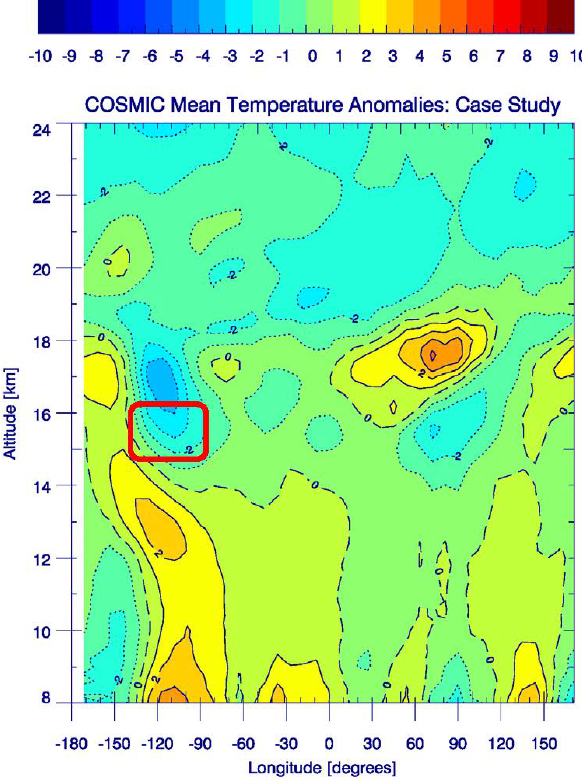
Fig. 7. Temperature anomalies as a function of longitude on 28 Jan- uary 2010 over 15 ◦ N–15 ◦ S. Anomalies are derived by subtracting the monthly mean temperature over the same latitude